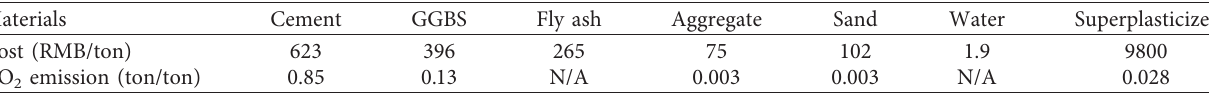
Table 5: Average cost and CO